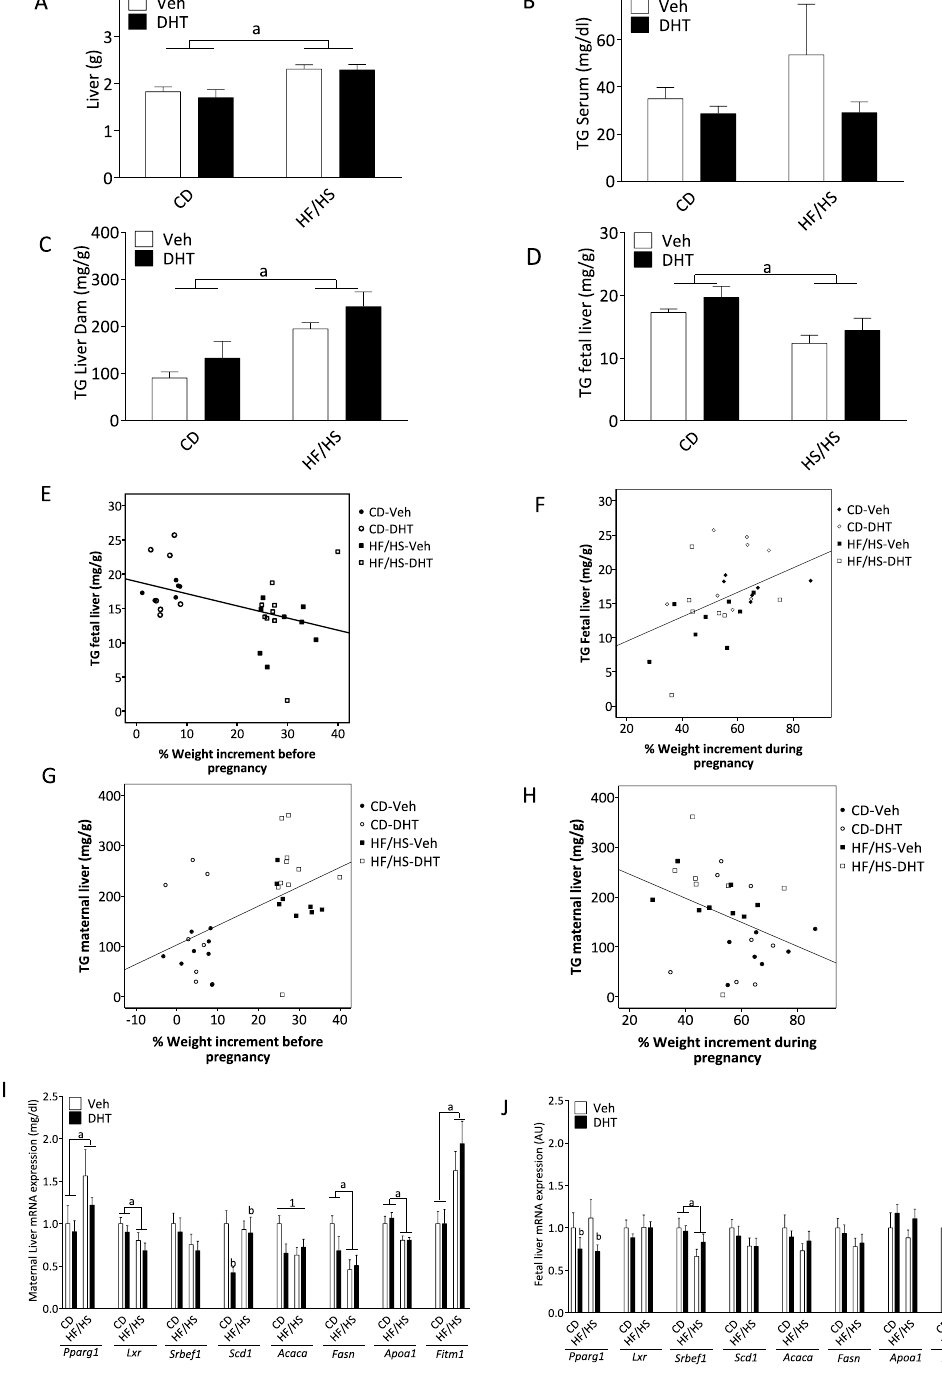
Figure 4. Liver weight, triglyceride content and gene expression of lipid metabolism markers in the maternal and fetal liver. ( A ) Weight of dams liver (CD-Veh, n = 8; HF/HS, n = 8; CD-DHT, n = 8; HF/HS-DHT, n = 10). ( B ) Circulating Triglycerides (TG) in serum and ( C ) TG content in dams liver, (CD-Veh, n = 8; HF/HS-Veh, n = 8; CD-DHT, n = 8; HF/HS-DHT, n = 9). ( D ) TG content in fetal liver (CD-Veh, n = 7; HF/HS, n = 8; CD- DHT, n = 8; HF/HS-DHT, n = 9). ( E ) Correlation analyses between TG content in fetal liver and maternal weight gain before pregnancy, ( F ) Correlation analyses between TG content in fetal liver and percentage of maternal weight gain during pregnancy, ( G ) Correlation analyses between TG content in maternal liver and percentage of maternal weight gain before pregnancy, ( H ) Correlation analyses between TG content in maternal liver and percentage of maternal weight gain during pregnancy, ( I ) Transcription factors, lipogenic enzymes, cholesterol and fat storage mediators in Maternal liver and ( J ) fetal liver (CD, n = 8; HF/HS, n = 8; CD-DHT, n = 7–8; HF/HS-DHT, n = 10). Values are means ± SEM. a = Main effect of diet, b = main effect of injection, 1 = Interaction between diet and